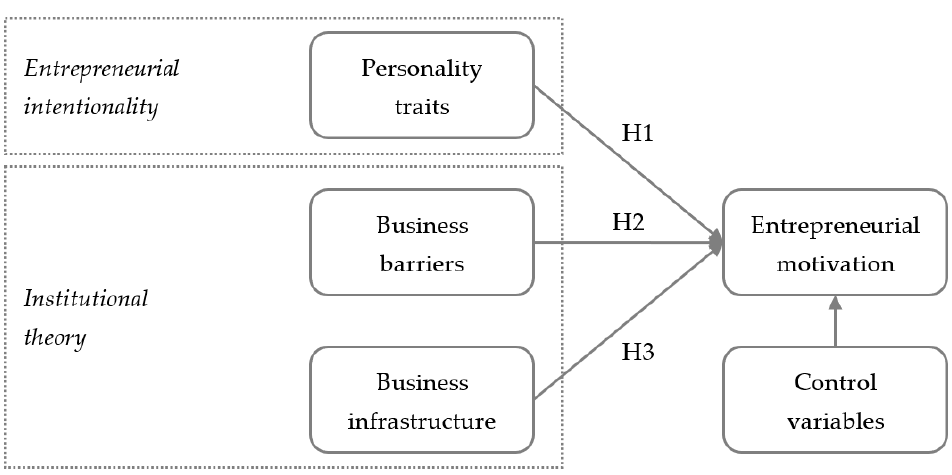
Figure 1 . Conceptual